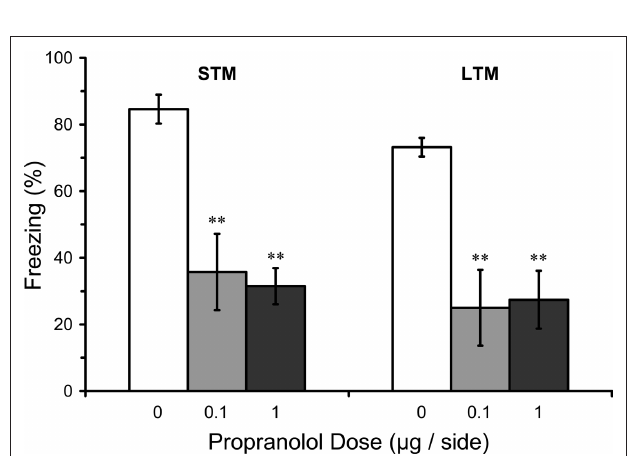
Figure 3 | Pre-training propranolol disrupts LTM for fear conditioning. Rats from Experiment 1 were given microinfusions of propranolol (0 μg, n = 6; 0.1 μg, n = 6; 1 μg, n = 7) into the lateral amygdala (LA) prior to three-trial auditory fear conditioning. Propranolol pre-treated rats showed attenuated long-term memory (LTM) for fear conditioning when tested drug-free 2 days later. The figure depicts mean freezing levels during the LTM test. ** indicates significantly lower freezing relative to vehicle ( p < 0.01).